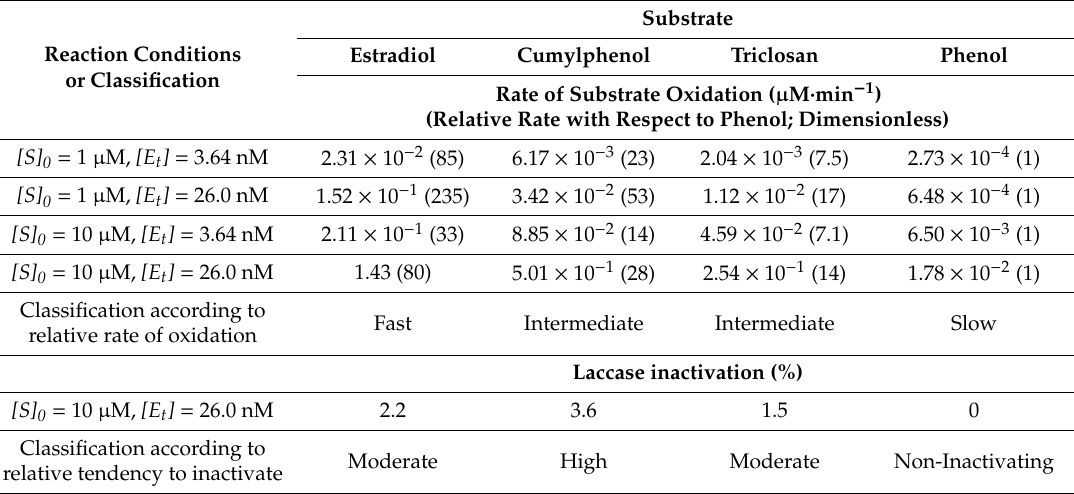
Table A2. Modeled average rates of substrate oxidation (and relative rates with respect to phenol) during the first minute of reactions conducted at high and low enzyme concentrations at pH 5.0 and 25 ◦ C. Also shown is the estimated percentage of enzyme inactivated over the first minute of the reaction modeled under conditions of high substrate and high enzyme concentrations where inactivation would be